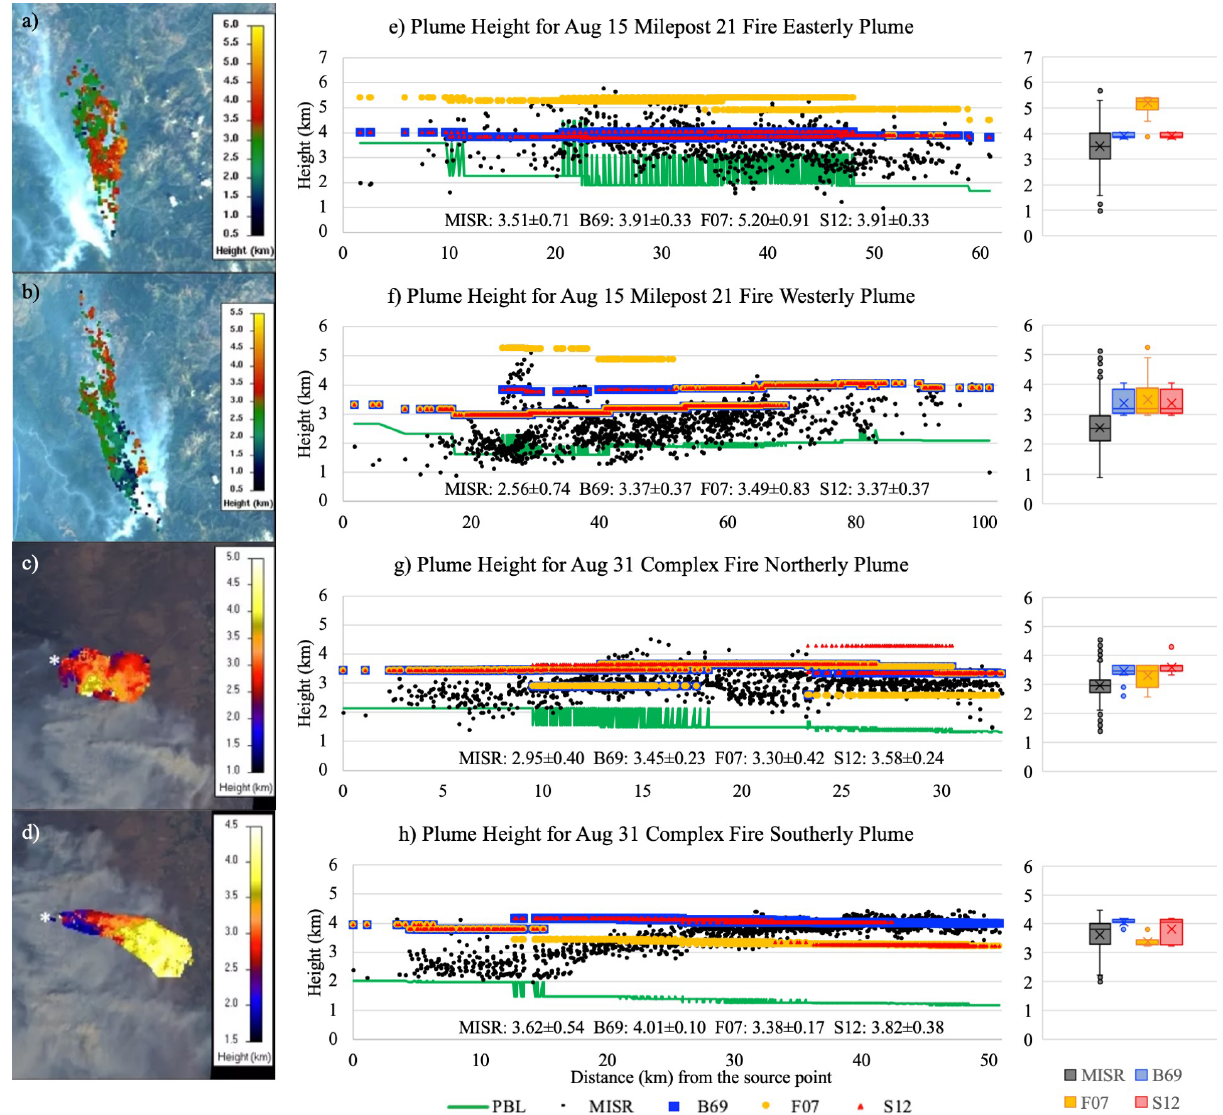
Figure 3. MISR plume heights superposed on the MODIS Terra visible images (a–d) and the comparisons of the observed plume height with the simulated plume heights (e–h) for the 15 August Milepost 21 fire easterly plume (a, e) and westerly plume (b, f) and the 31 Au- gust Complex fire northerly plume (c, g) and southerly plume (d, h) . Source: MISR Active Aerosol Plume-Height (AAP) Project, with Ralph A. Kahn, Katherine J. Noyes, James Limbacher (NASA Goddard Space Flight Center), Abigail Nastan (JPL-Caltech), Jason Tackett, and Jean-Paul Vernier (NASA Langley Research